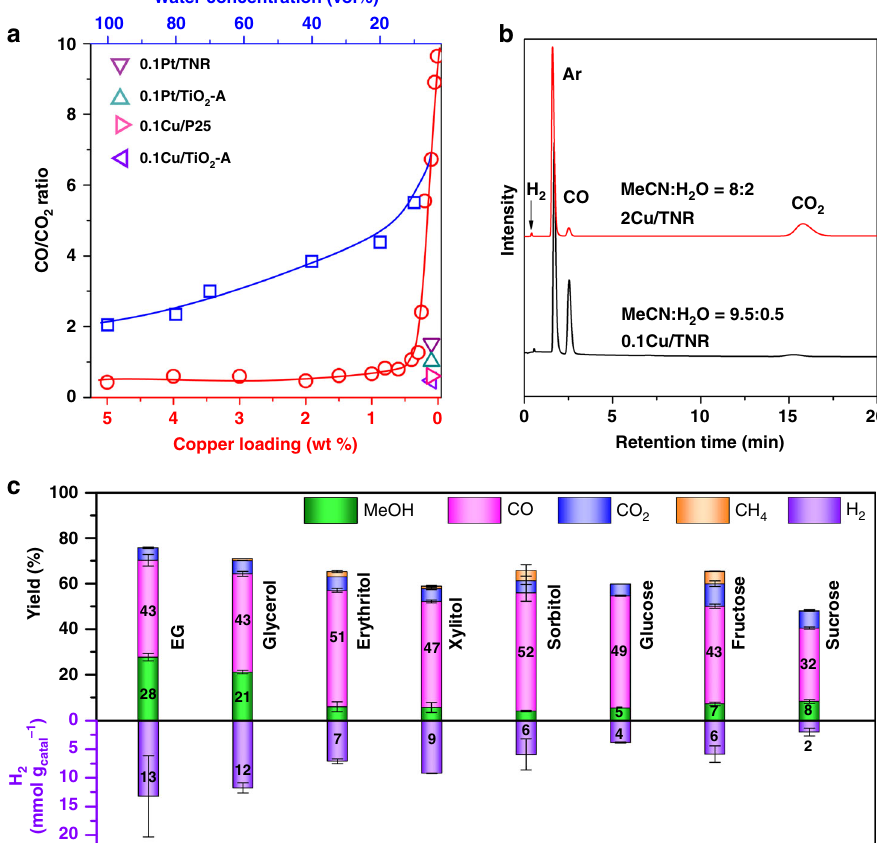
Fig. 3 Conversion of biomass resources to syngas. a The effect of water content and copper loading on the ratio of CO/CO 2 . Reaction conditions: 10 mg of glycerol, 10 mg of catalyst, 365 nm LED (18 W, 55 mW cm − 2 ) irradiation for 12 h. For the investigation of water concentration effect, 0.1Cu/TNR was used as a catalyst. For the investigation of copper loading effect, 0.95 mL of MeCN and 0.05 mL of water was used as solvent. b GC curves of the gas products. c Photo-reforming of different polyols. Error bar represents the standard deviation. Detailed reaction conditions and product analysis are presented in Supplementary Table